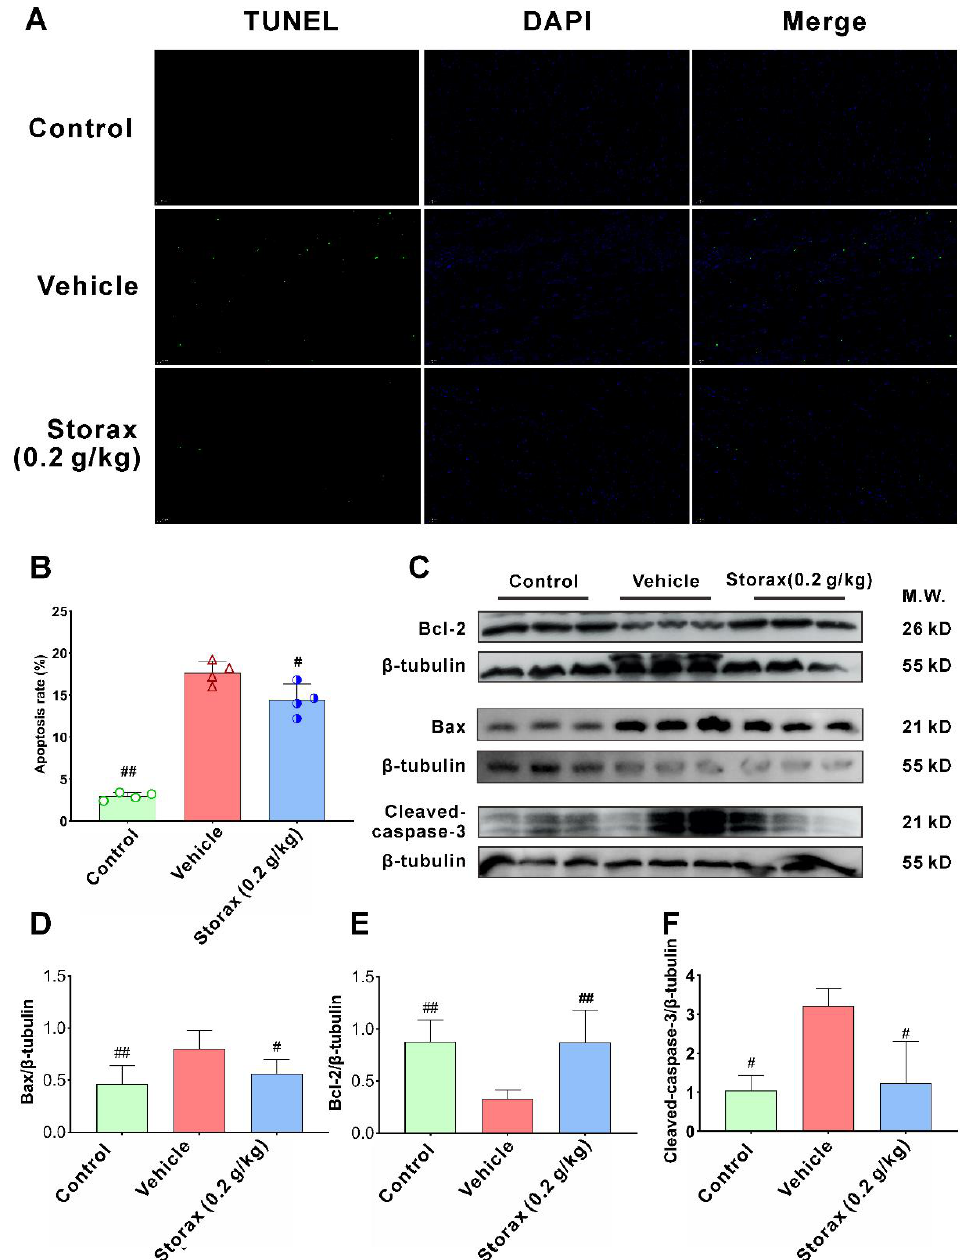
Figure 7. Effects of storax on cardiomyocyte apoptosis in the myocardium of ISO-induced AMI rats. ( A ) Representative images of terminal deoxynucleotidyl-transferase-mediated dUTP nick end labeling (TUNEL) staining. TUNEL-positive apoptotic cells were shown in green and DAPI nuclear staining was shown in blue (scale bar = 50 μm). ( B ) Quantitative analysis of TUNEL-positive cells (n = 4). ( C ) The protein expression levels of Bax, Bcl-2 and cleaved Caspase-3 in rat cardiac tissue of each group were shown by Western blotting (WB) bands. ( D – F ) Relative protein for Bax, Bcl-2 and cleaved Caspase-3 were quantified by densitometry based on immunoblot images. Results are pre- sented as mean ± SD (n = 3). One-way ANOVA followed by Bonferroni’s post hoc test: # p < 0.05, ## p < 0.01 vs. vehicle group.